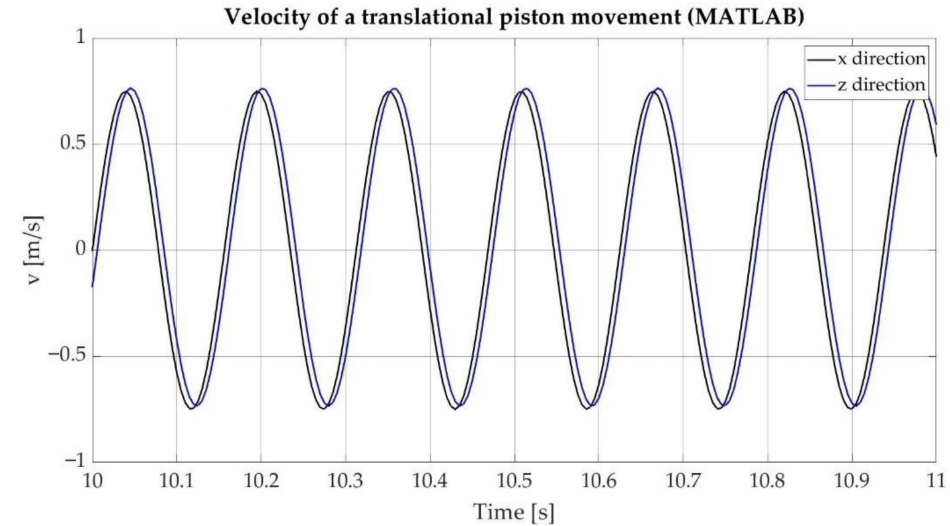
Figure 11. Translational velocity of pistons—results from MATLAB.